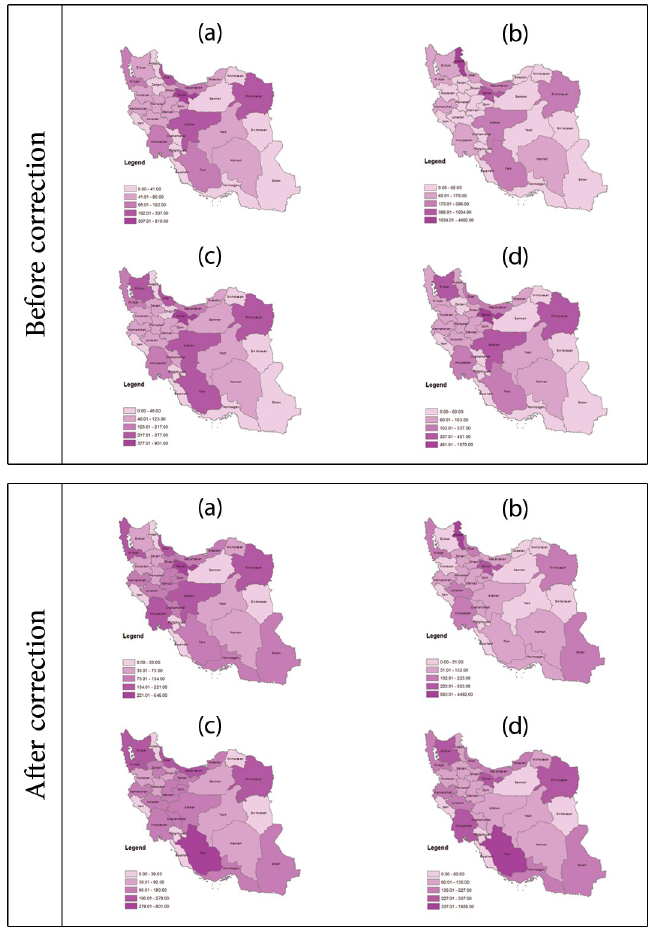
Fig 2. Distribution of colorectal cancer incidence in Iran before and after misclassification error correction since 2005 to 2009. (a) 2005, (b) 2006, (c) 2007, (d)